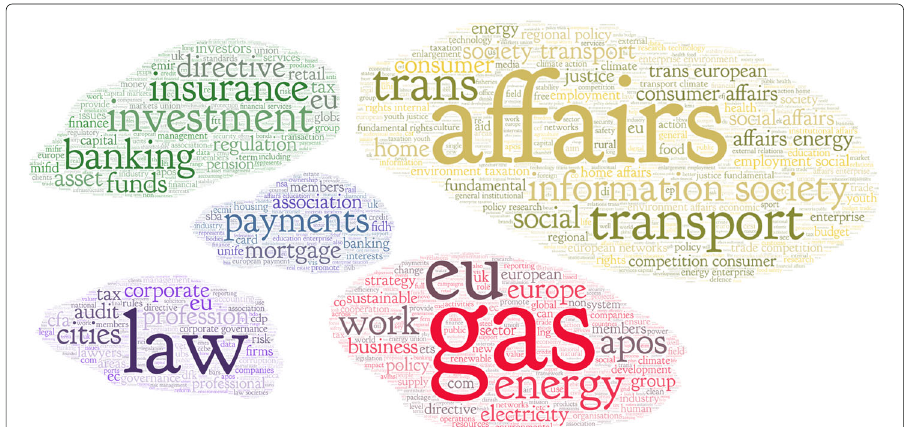
Fig. 3 Tag clouds of the five clusters of organizations. The tag clouds are constructed from the self-described goals and activities of the 565 lobby organizations. Size of the clouds is proportional to the number of organizations in them